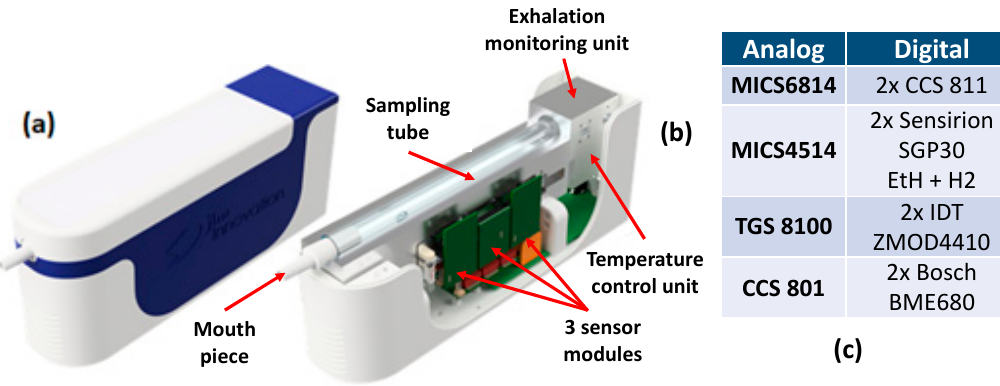
Figure 1. External ( a ) and internal view of the MBA system ( b ), and list of MOX sensors ( c ).